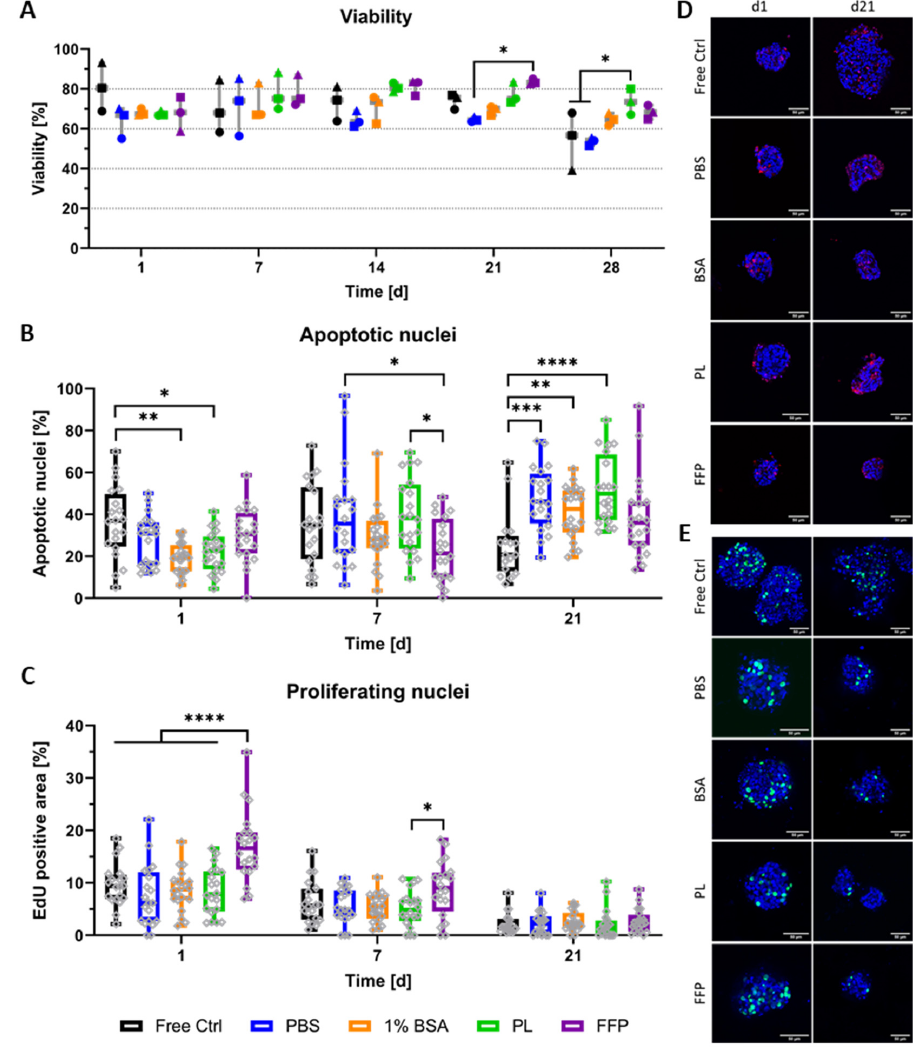
Figure 3. Viability and proliferation of bioprinted NICC in supplemented algMC. Analysed groups are free control NICC in suspension culture and NICC bioprinted in PBS-algMC, BSA-algMC, PL-algMC, and FFP-algMC. ( A ) Semi-quantitative analysis of live/dead staining, the different symbols represent the different experiments depicted, mean ± SD, n = 3, >25 NICC each; ( B ) Quantitative analysis of percent apoptotic nuclei per islet, mean ± SD, n = 1, 20 NICC; ( C ) Quantitative analysis of proliferating nuclei. Mean area of proliferating nuclei in percent of total islet area, mean ± SD, n = 1, 20 NICC; ( D ) TUNEL staining for apoptotic nuclei in bioprinted NICC, representative images of samples fixed on d1 and d21 after bioprinting, scale bars = 50 µm; ( E ) EdU staining for nuclei of cells that proliferated within 24 h before fixation, representative images of samples fixed on d1 and d21 after bioprinting, scale bars = 50 µm. Grey dots in a-c indicate individual islets, significances indicate * p < 0.05, ** p < 0.01, *** p < 0.001, **** p < 0.0001.